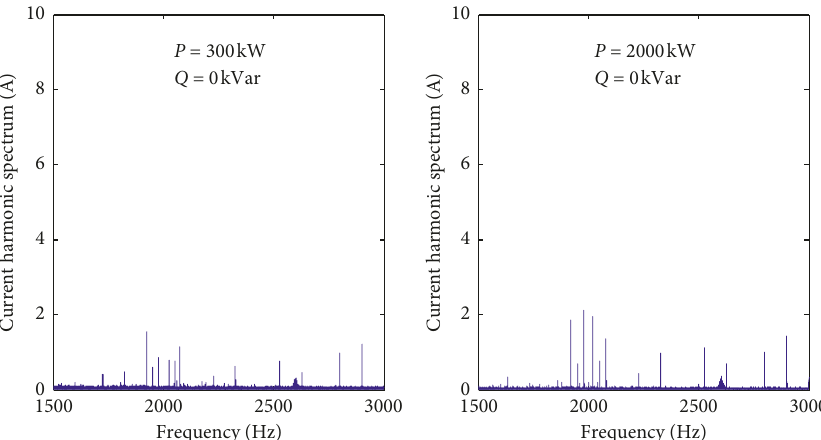
Figure 18: Current waveforms and harmonic spectrum of the DFIG under different active power